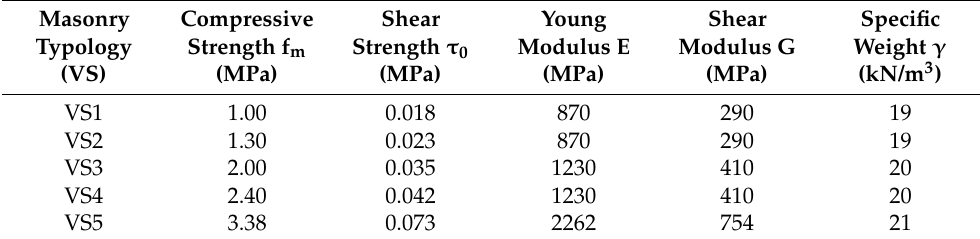
Table 1. Mechanical properties of the five masonry